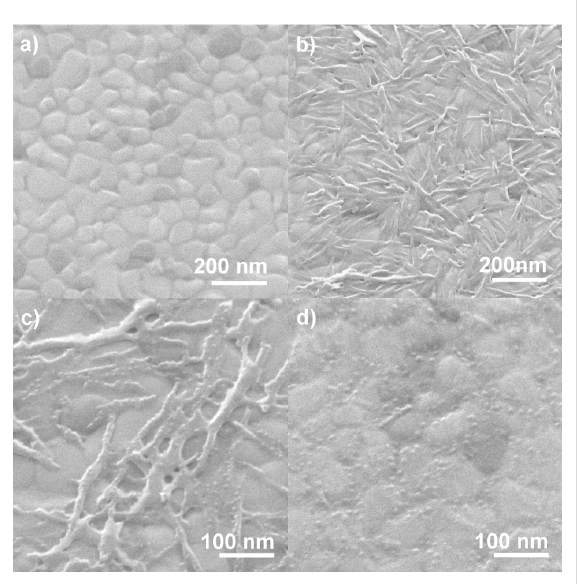
Figure 4: HIM images of samples after different steps of preparation and electron exposure. (a) Au substrate covered with carboxy-termi- nated SAM, (b) after growing on the SAM copper(II) oxalate by 16 deposition cycles, and analogous layers after electron exposure of (c) 2000 μ C/cm 2 and (d) 8000 μ C/cm² at 500 eV.